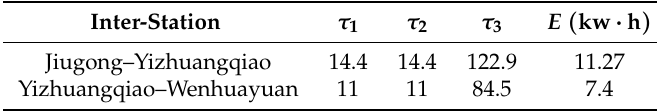
Figure 5. Optimal speed trajectory of Yizhuangqiao–Wenhuayuan. ( a ) The speed trajectory w.r.t. the position; ( b ) The speed trajectory w.r.t. the time. Table 2. The optimal ¯ τ and energy